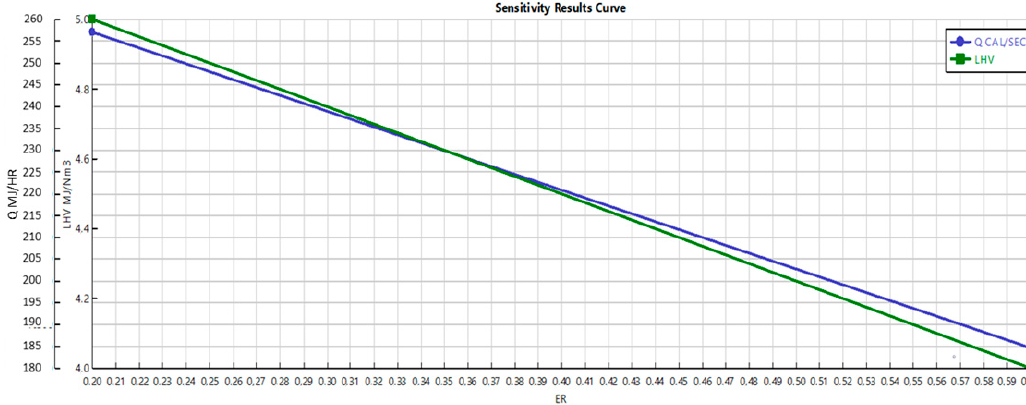
Figure 6. Gasifier heat demand and LHV vs. ER.